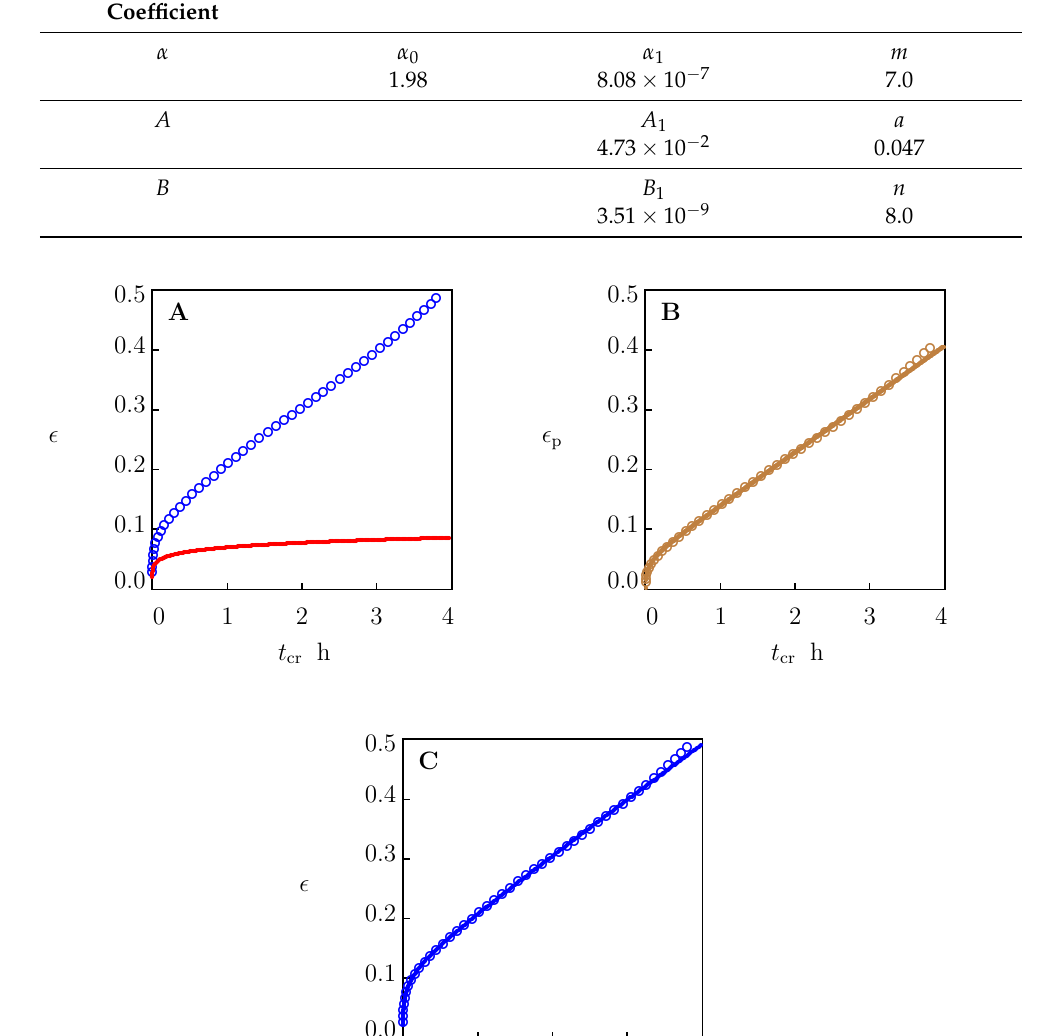
Table 2. Material parameters for the viscoplastic response.